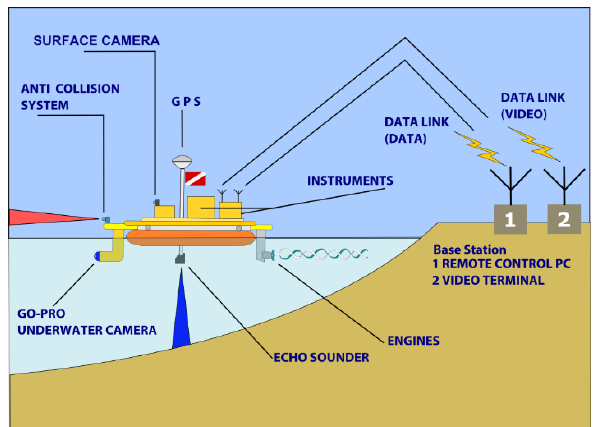
Figure 5. Architecture of the data acquisition system of the drone MicroVEGA